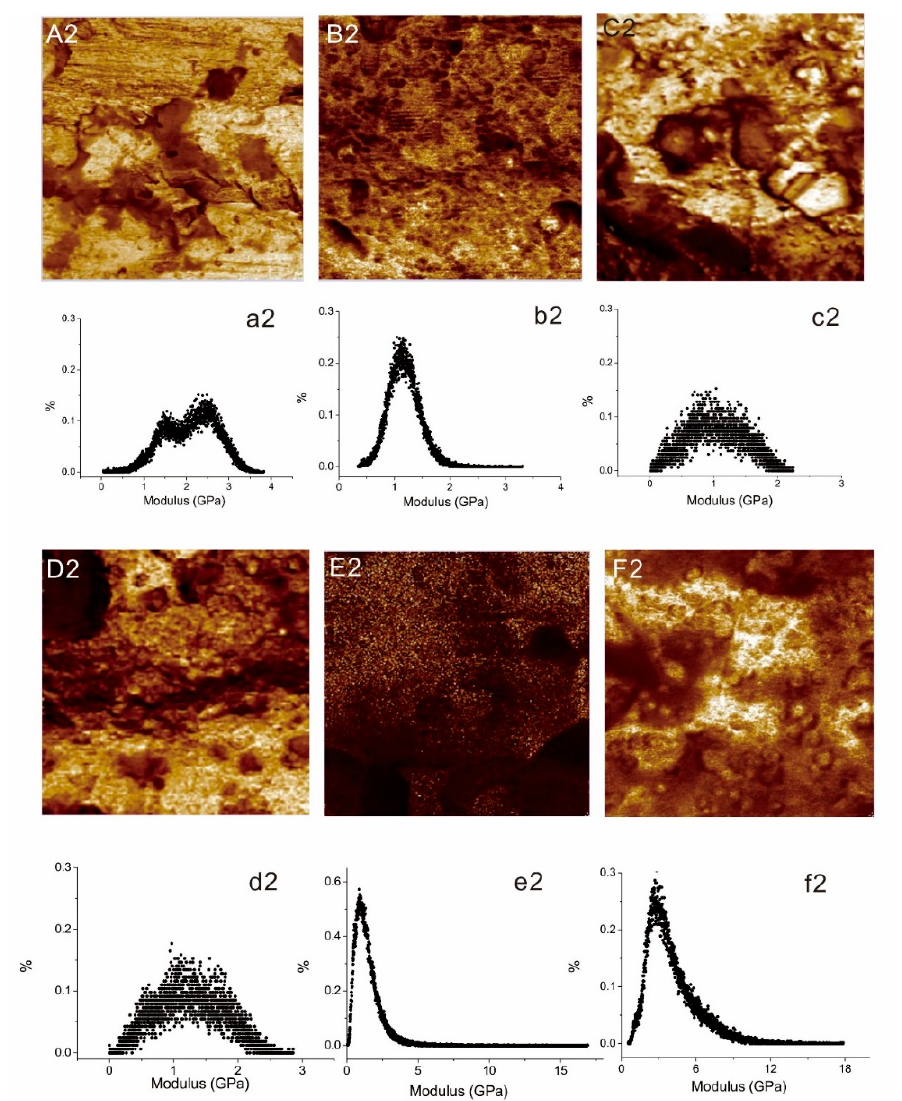
Figure 5. AFM Derjaguin–Muller–Toporov (DMT) modulus maps of a 3 × 3 μ m 2 region, and the modulus distribution graphs of ( A2, a2 ) Al alloy; ( B2, b2 ) MP; ( C2, c2 ) MPAL; ( D2, d2 ) MPALSi; ( E2, e2 ) P2; ( F2, f2 ) P2Si.